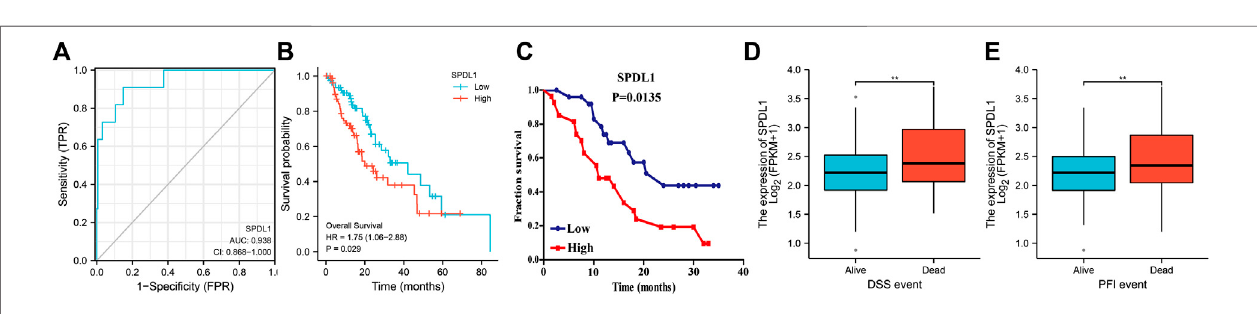
FIGURE 5 | SPDL1 expression levels in diagnosing ESCA and evaluating the prognosis of patients. (A) Diagnostic value; (B, C) OS; (D) DSS; (E) and PFI. OS, overall survival; DSS, disease-speci fi c survival; PFI, progression-free interval; ESCA, esophageal cancer; SPDL1, spindle apparatus coiled-coil protein